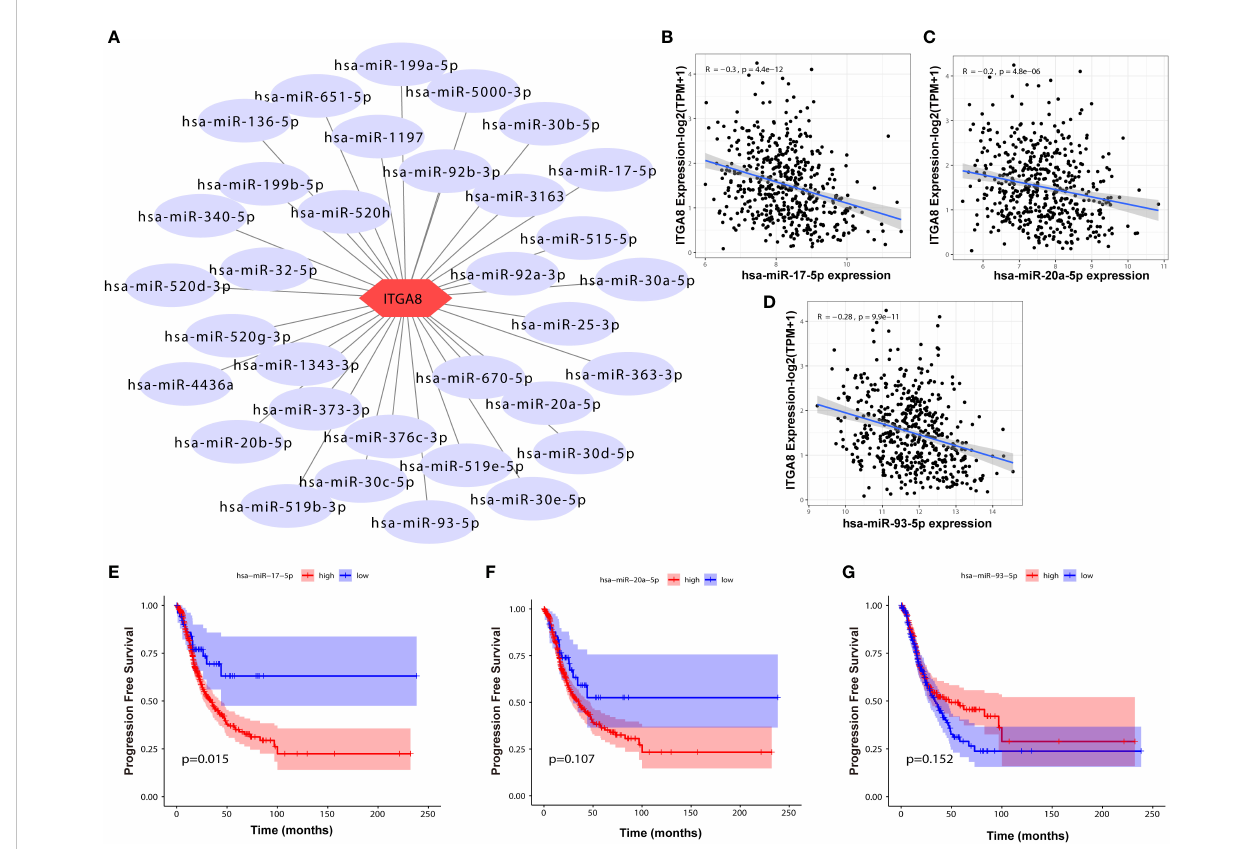
FIGURE 5 Correlation analyses between the expression of miRNAs and ITGA8. (A) The network map of miRNAs that may affect the expression of ITGA8. (B) Correlation analysis between the expression of miR-17-5p and ITGA8 ( r = − 0.3, p < 0.001). (C) Correlation analysis between the expression of miR-20a-5p and ITGA8 ( r = − 0.2, p < 0.001). (D) Correlation analysis between the expression of miR-93-5p and ITGA8 ( r = − 0.28, p < 0.001). PFS-based Kaplan – Meier survival analyses of (E) miR-17-5p ( p = 0.015), (F) miR-20a-5p ( p = 0.107), and (G) miR-93-5p ( p = 0.152). The expression level of ITGA8 gene was marked as Log 2(TPM+1) Scale.